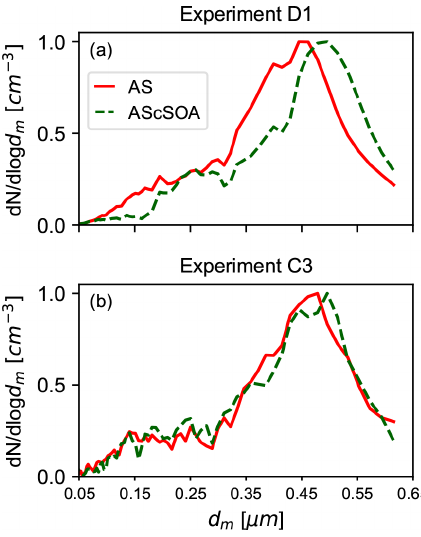
Figure 3. Comparison of the normalized particle number size distri- bution before and after the coating procedure. The x axes represent the electrical mobility diameter d m . (a) Particle number size distri- bution for experiment D1 before (red) and after (green) the coating process. The thick organic coating was performed in the APC cham- ber. (b) Particle number size distribution for experiment C3 before (red) and at the end (green) of the in situ coating procedure. The thin coating experiments were performed stepwise and with lower concentrations of the gas precursor in the AIDA chamber. No ap- parent shift in the particle number size distribution was detected for experiments of type